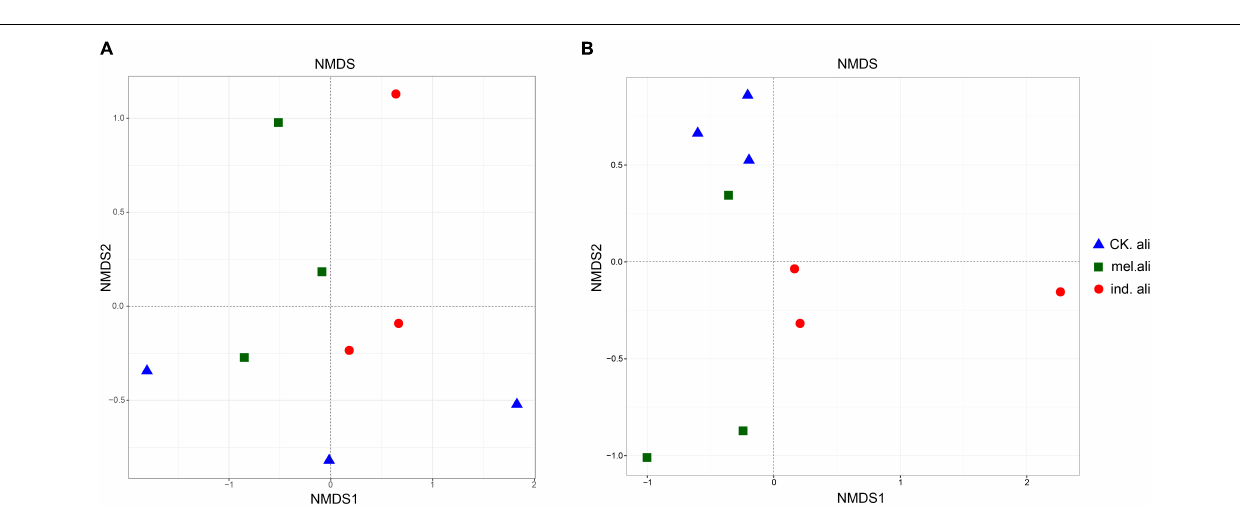
FIGURE 5 | Non-metric multidimensional scaling (NMDS) plots of (A) nirK - and (B) nirS -type denitrifying bacterial communities in rhizosphere soil of Quercus aliena . CK.ali, rhizosphere soil of Q. aliena without Tuber partner; mel.ali, ectomycorrhizosphere soil of Q. aliena with Tuber melanosporum partner; and ind.ali, ectomycorrhizosphere soil of Q. aliena with Tuber indicum